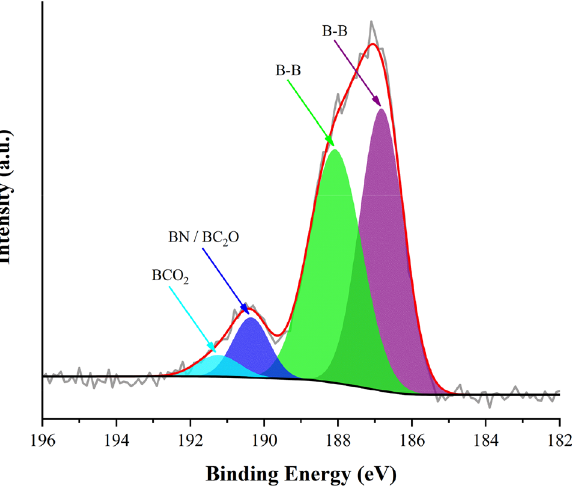
Figure 4. X-ray photoelectron spectroscopy (XPS) measurements in B 1 s region of washed B NPs produced without Ar